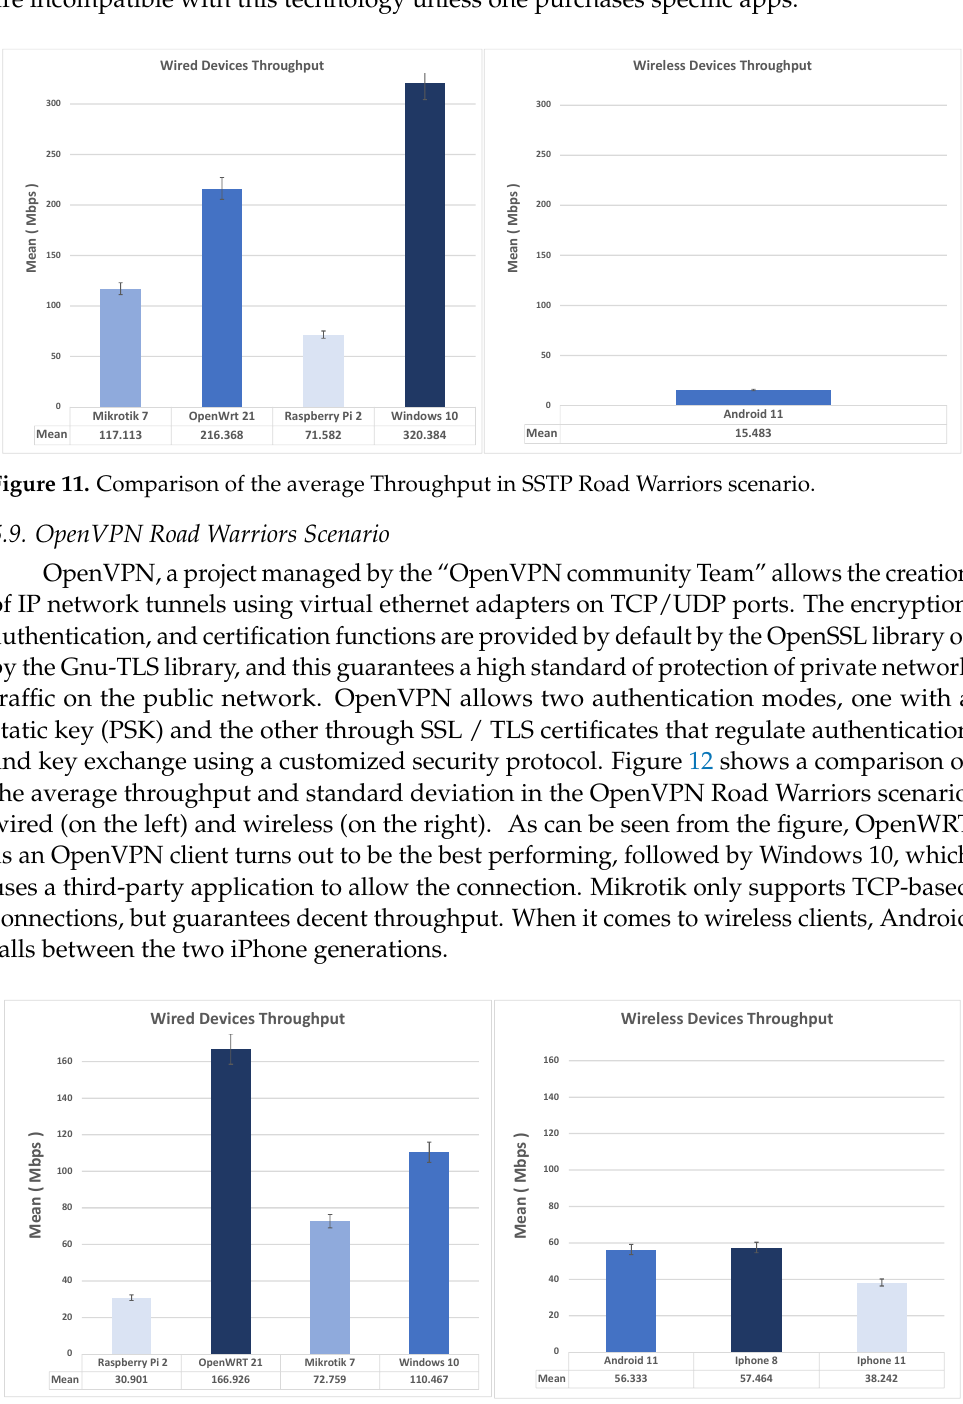
Figure 12. Comparison of the average Throughput in OpenVPN Road Warriors